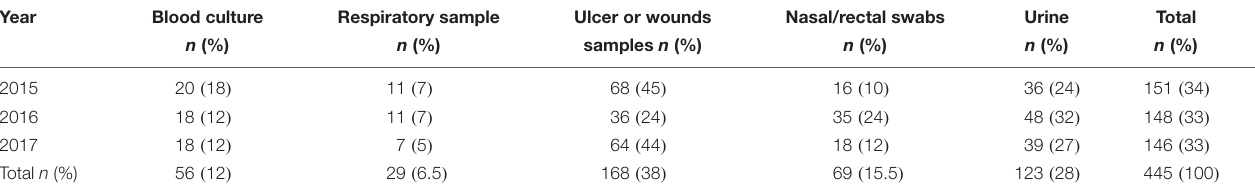
TABLE 2 | Source of Enterobacter isolates during the years 2015–2017: type of samples